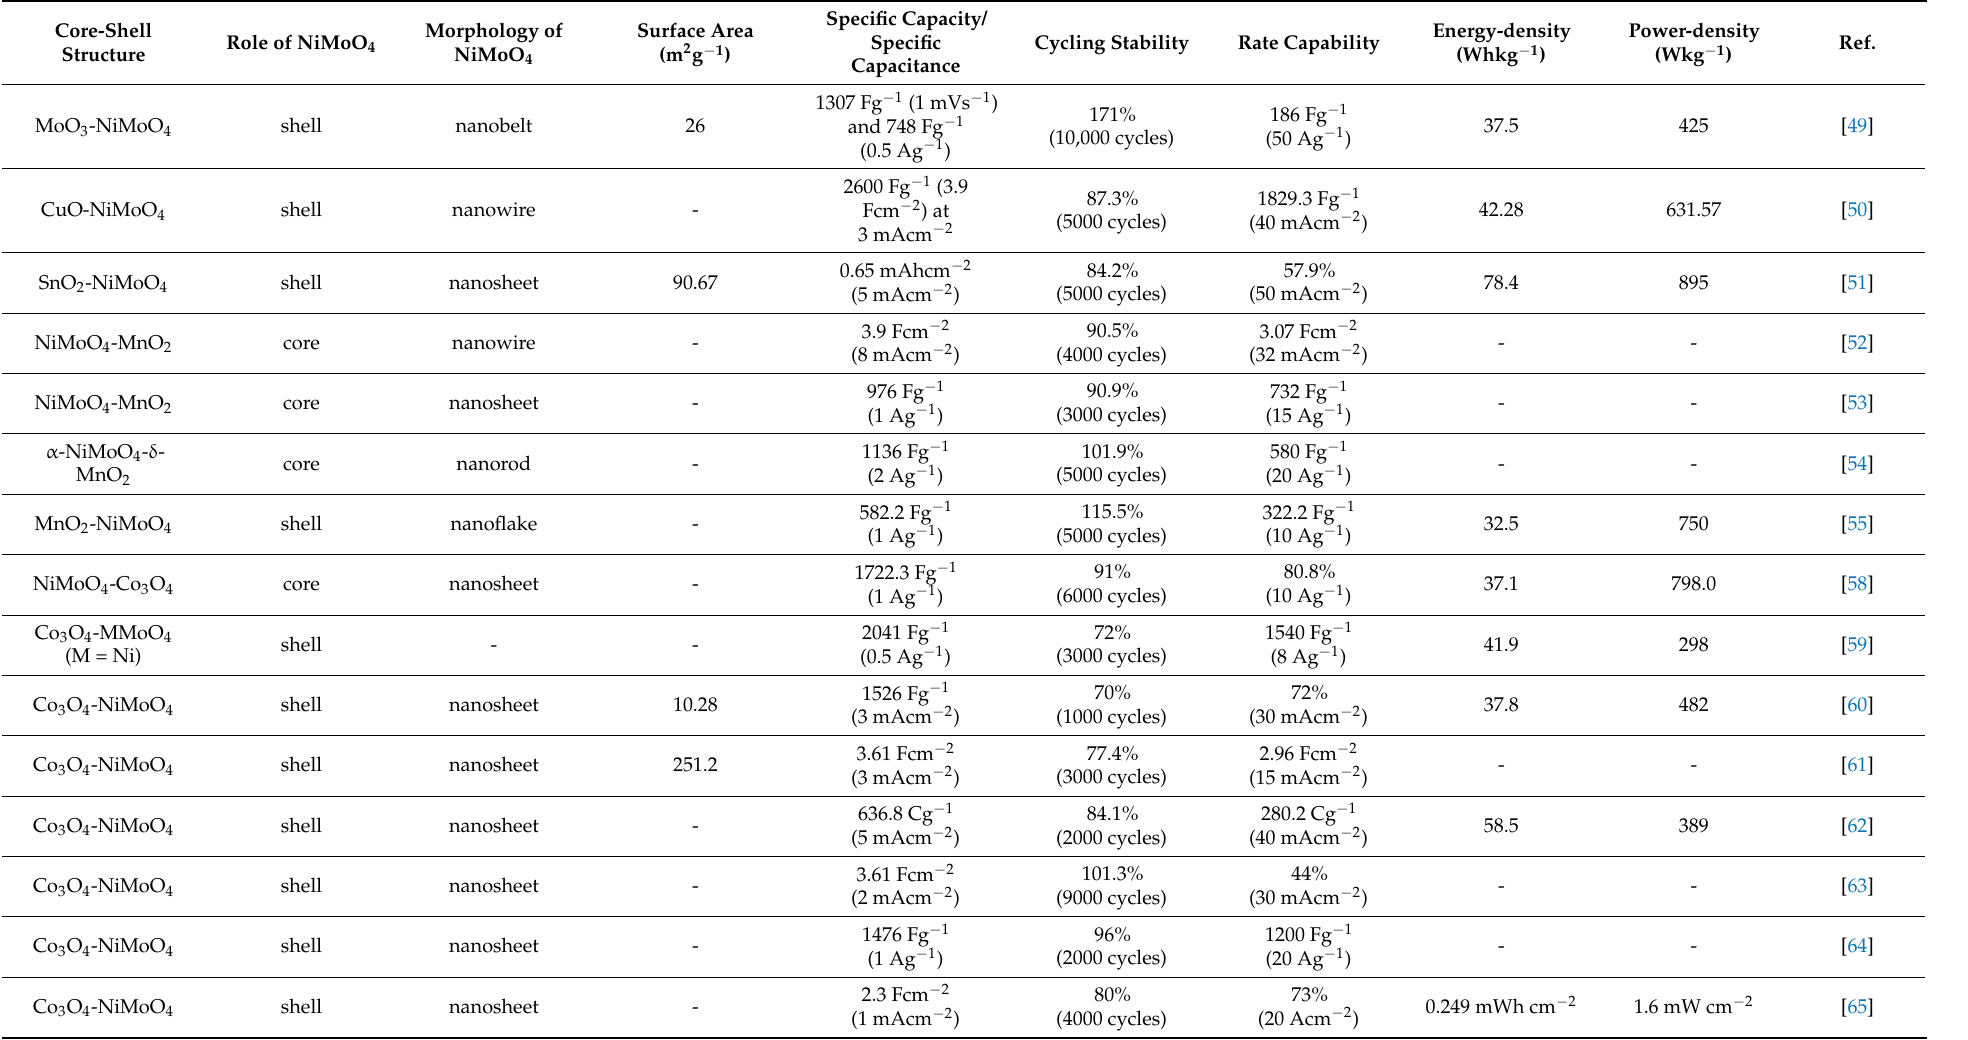
Table 1. Electrochemical performances of the core-shell structures based on the NiMoO 4 -metal oxide composite for